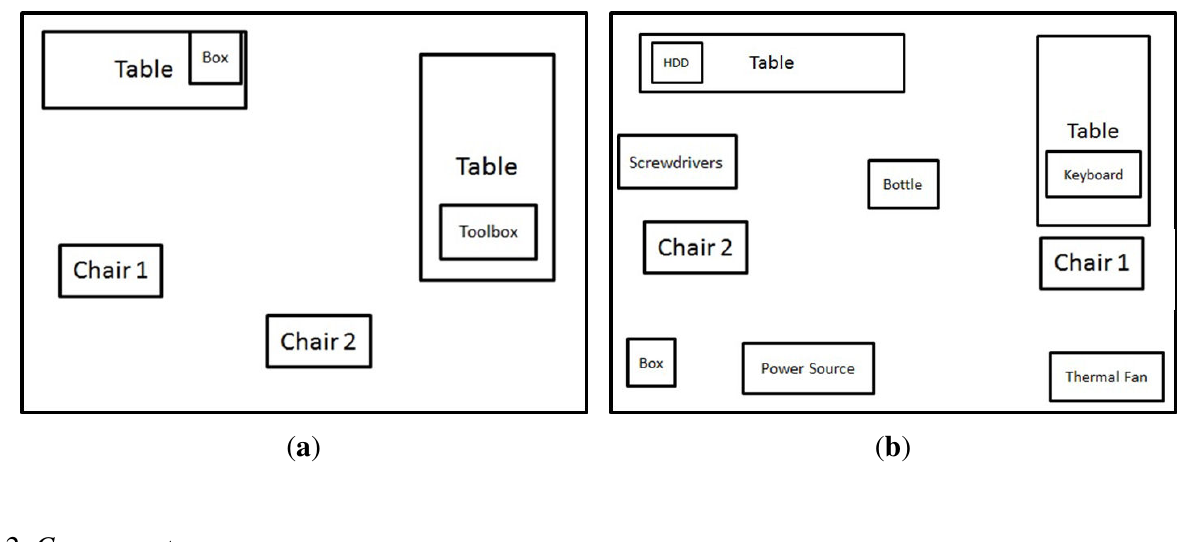
Figure 11. Scenarios 1 and 2. ( a ) Scenario 1; and ( b ) Scenario 2.